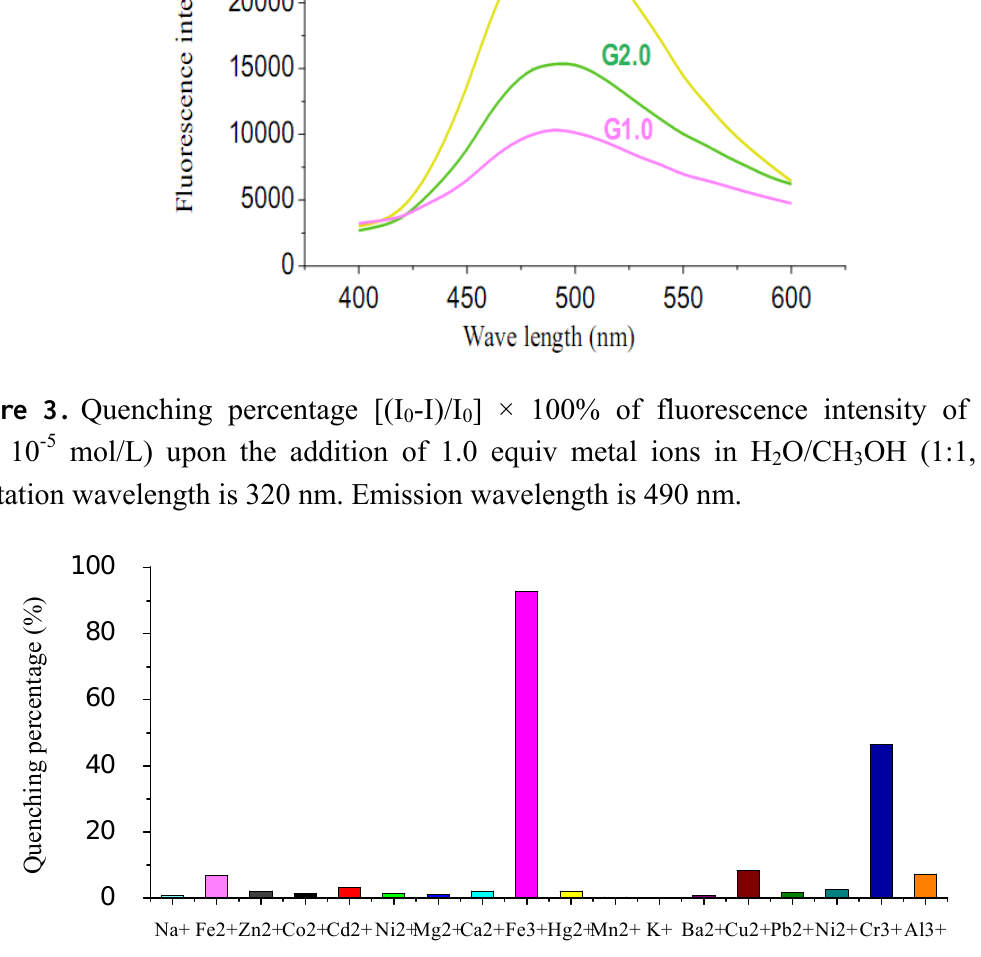
Figure 2. Fluorescent spectra of 5 × 10 -5 mol/L G3.0, G2.0, G1.0 in H v/v ). Excitation wavelength is 320 nm. Emission wavelength is 490 nm.